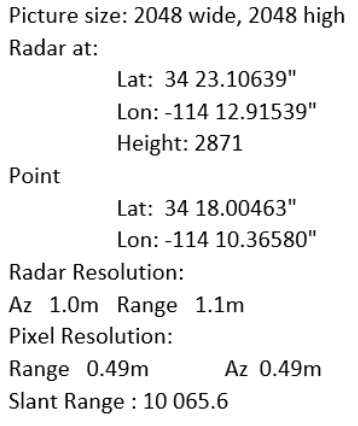
Figure 2. Sample metadata of the SAR’s scan. Pixel resolution is